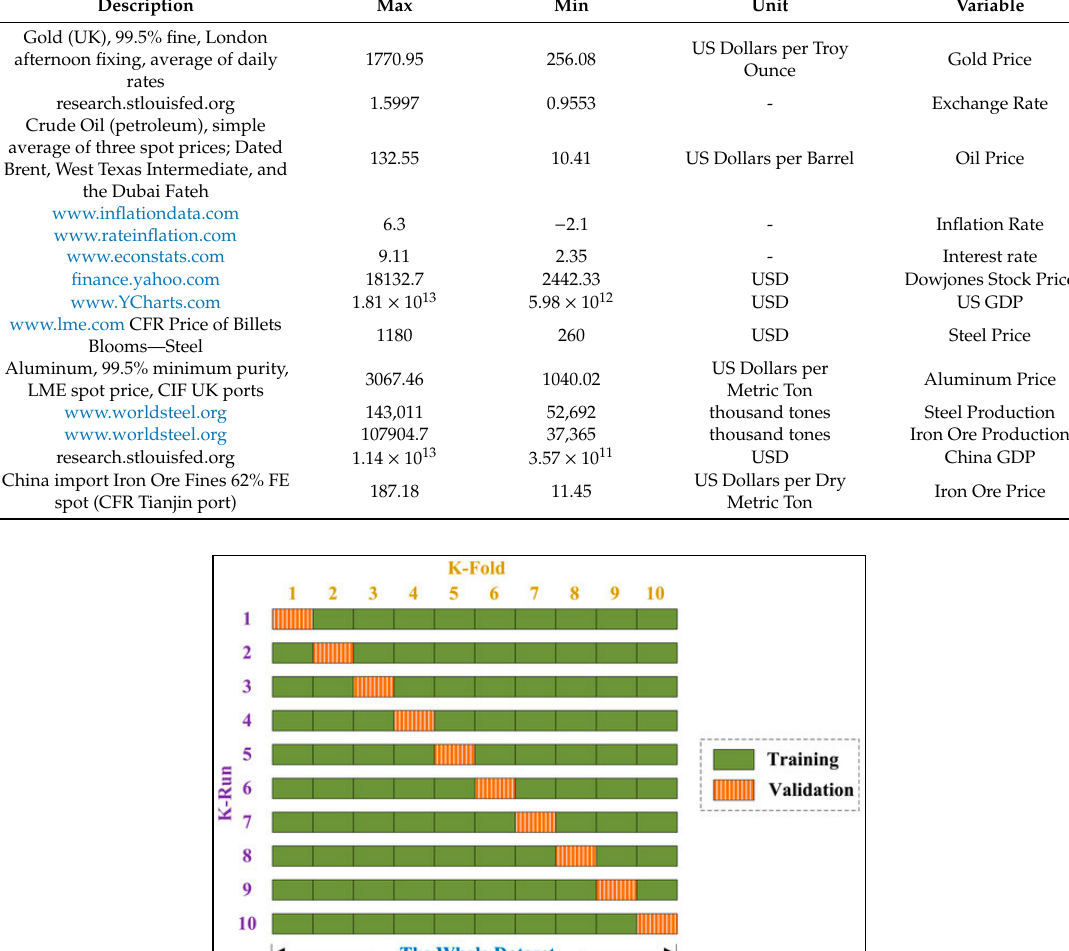
Table 1. Introducing input and output parameters in the modeling.